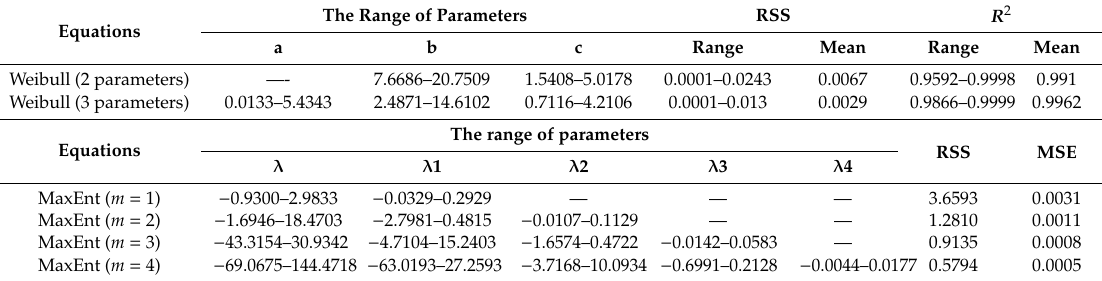
Table 3. The mathematical characteristics of parameters and statistics for Weibull distribution and MaxEnt distribution derived from the 130 plot